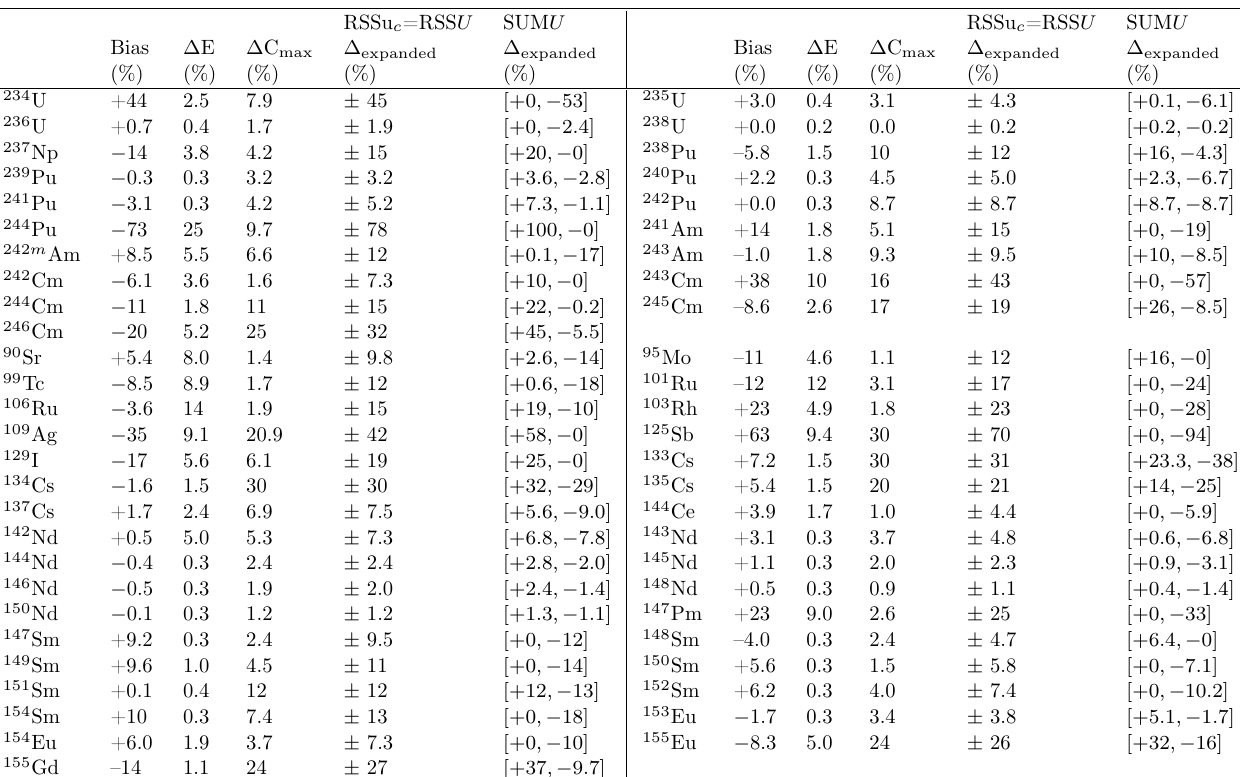
Table B.6. Expanded estimated uncertainties ∆ expanded on isotopic concentrations for GU3’, taking into account the calculation bias and the experimental and calculated uncertainties. ∆ C max come from the nuclear data library leading to the highest nuclear data uncertainty (either ENDF/B-VIII.0, JEFF-3.3 or JENDL-4.0). Three combination methods are presented: RSSu c , RSS U (being equal to RSSu c for 1 σ ), and SUM U